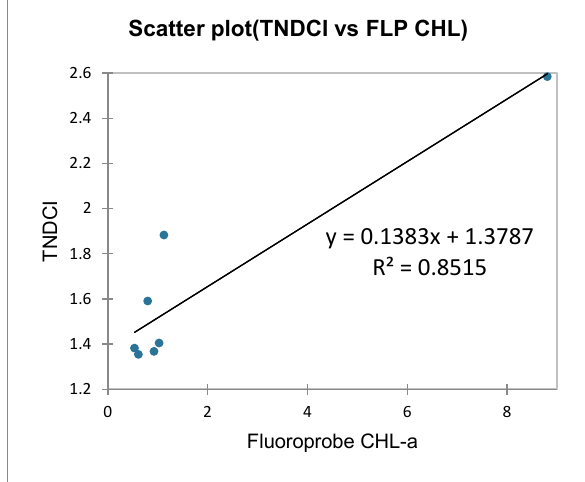
Figure 7. Scatterplot for TNDCI and Fluoroprobe chlorophyll-a